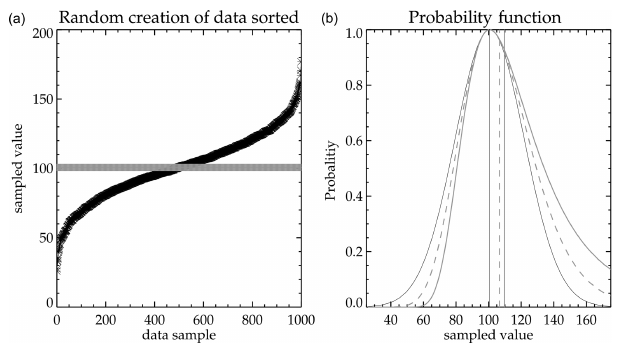
Figure 3. This shows how a randomly sampled measurement within a volume would compare to a whole sample volume-averaged mea- surement. The left panel shows randomly generated measurements based on a Gaussian distribution having a mean value of 100 with a standard deviation of 25. The + symbols represent the individu- ally generated measurements (as measured in situ) that make up an average value of 100 (as measured remotely). Panel (a) shows the probability of measuring a particular difference based on how that difference is computed. Thin black is y − x , thick gray is (y − x)/x , and thick dashed gray is 2 (y − x)/(x + y) . The vertical lines are their means.